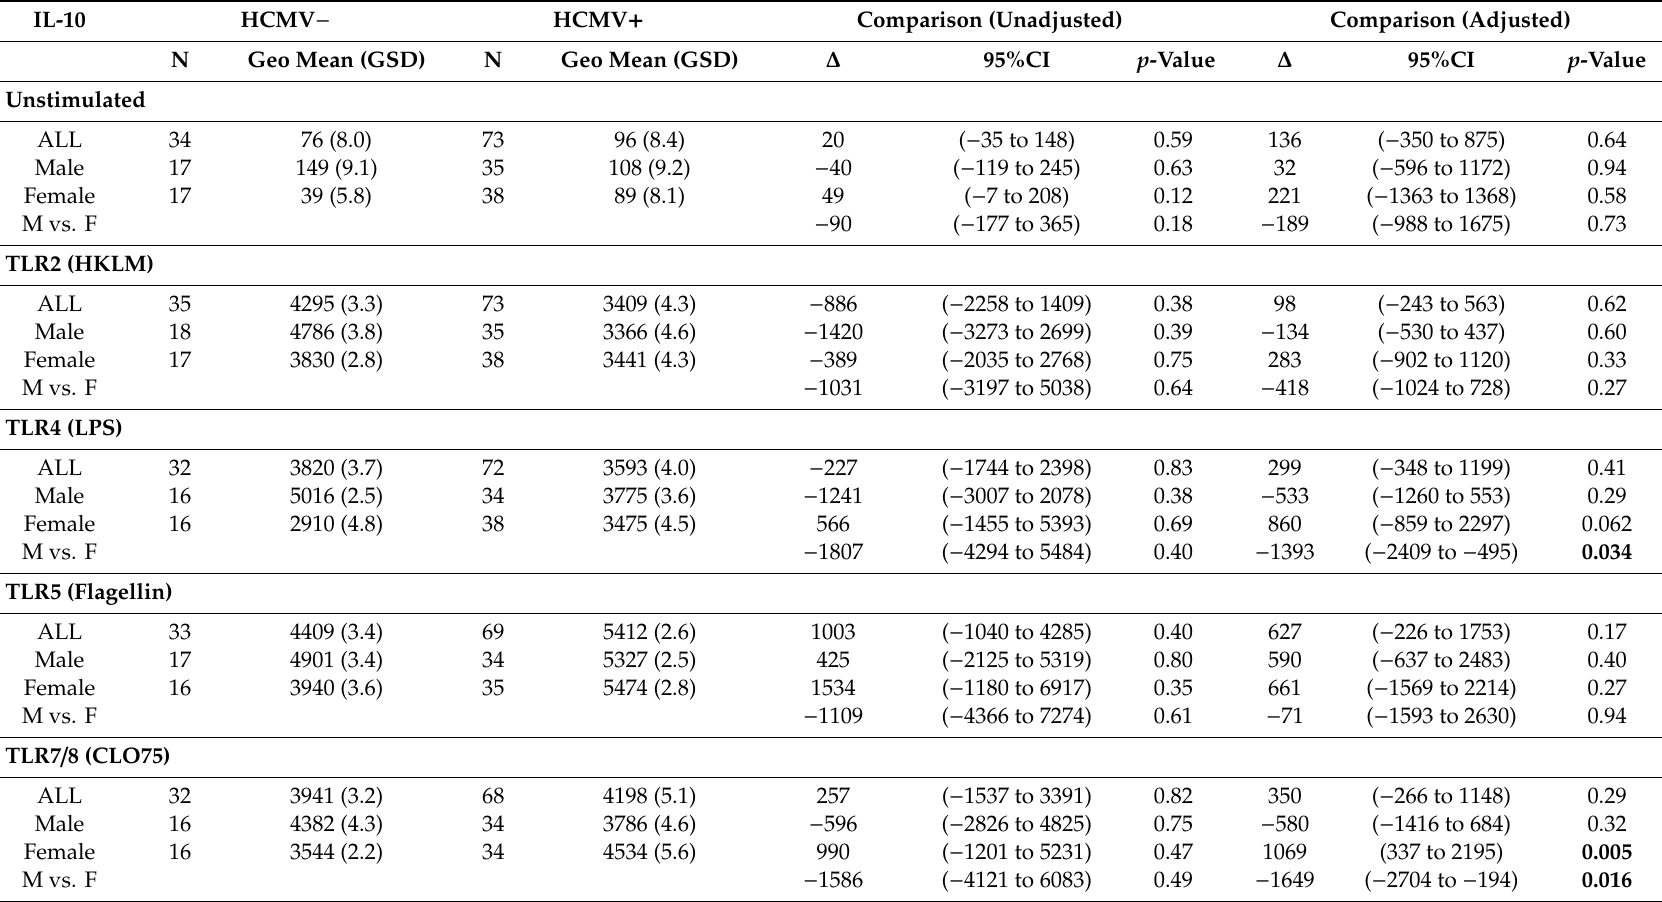
Table 6. E ff ect of HCMV infection on TLR ligand-stimulated IL-10 responses by infant